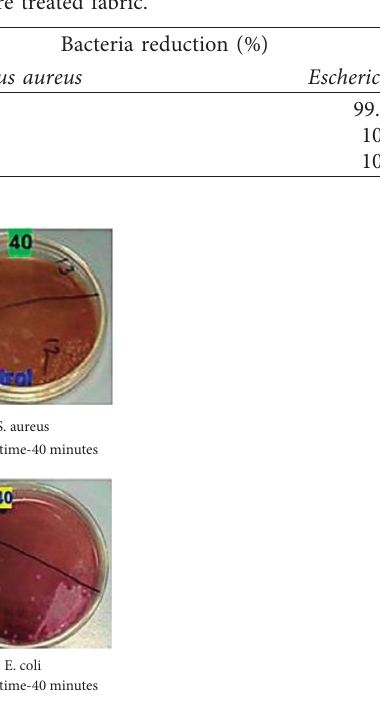
Figure 6: The test results of Pad-Dry-Cure antibacterial treated fabric for Staphylococcus aureus and Escherichia coli .